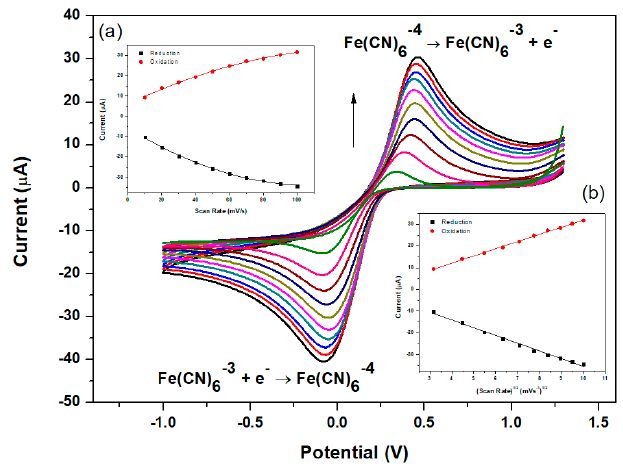
Figure 7. Electrochemical characterization of NGr-DMG-GCE in 5 mM Fe(CN) 63 − /4 − at scan rate of 10–100 mV s − 1 in supporting electrolyte (1 M KCl). Insets: plots of peak currents vs. ( a ) scan rate and ( b ) scan rate1/2 of the main oxidation and reduction waves.